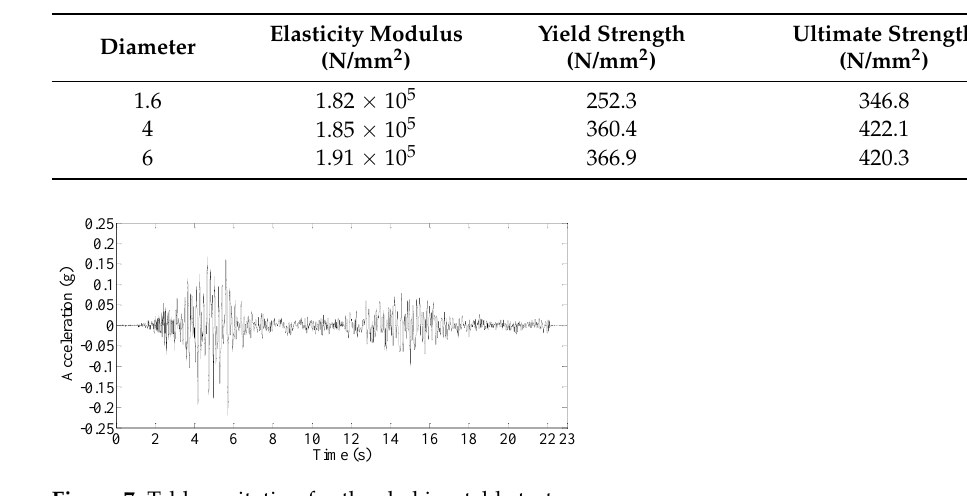
Figure 7. Table excitation for the shaking-table test.